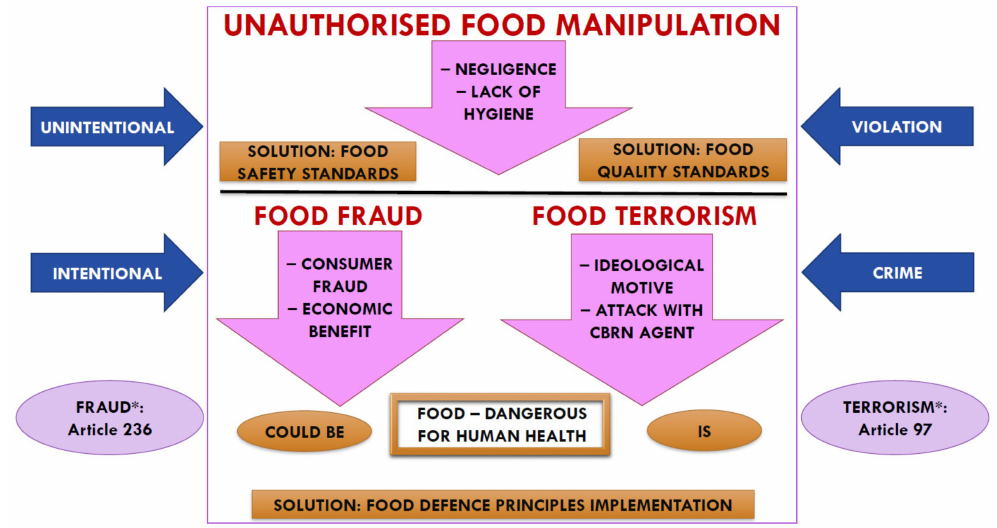
Figure 1. Unauthorized food manipulations (UFMs), law violations, and criminal offenses. * As defined by Croatian Criminal Law (NN 125/11, 144/12, 56/15, 61/15, 101/17, 118/18, 126/19,